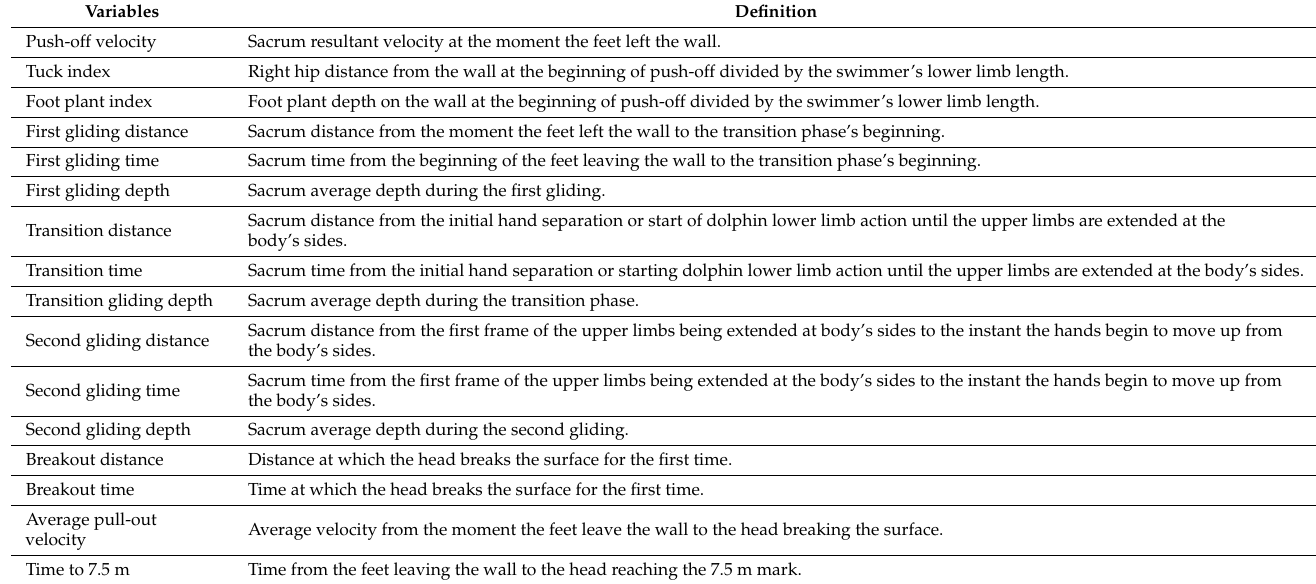
Table 1. Kinematic variables selected to analyze the pull-out strategies of backstroke-to-breaststroke turning techniques. Variables Definition Push-off velocity Sacrum resultant velocity at the moment the feet left the wall. Tuck